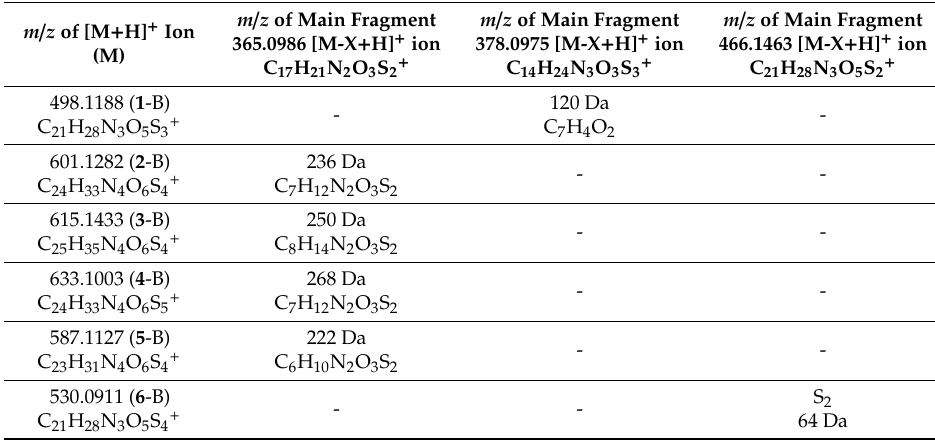
Table 10. Selected main fragments caused by di ff erent NL recorded during MS 2 experiments for the B isomers of the novel derivatives of Ybt by application of LC-MS / HRMS. All recorded fragmentation spectra are shown in the Supplementary Material. The specific NL [X] of a fragment leading to the ions [M-X + H] + listed on top of the columns are noted in the